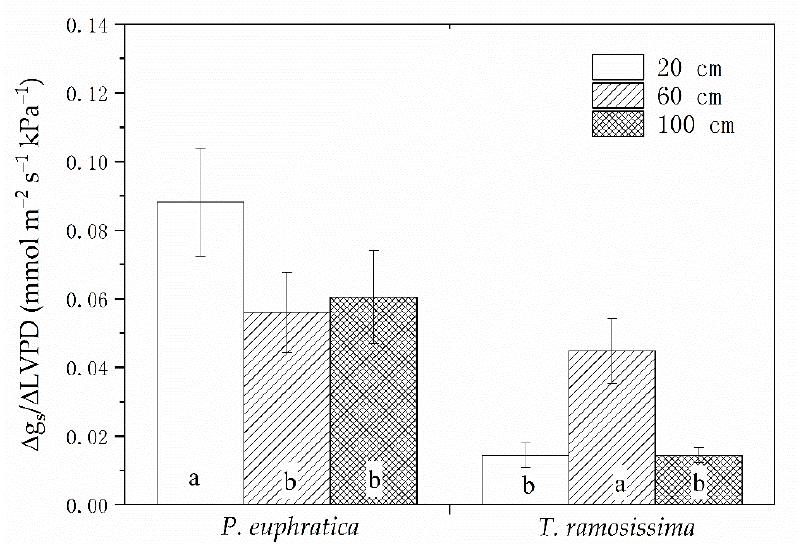
Figure 6. Stomatal conductance in response to increases in leaf-to-air vapor pressure deficit ( LVPD ) expressed as the ratio of Δ g s to Δ LVPD. Values are mean ± SE. Letters indicate significant differences among treatments for each species as determined by ANOVA ( p < 0.05).